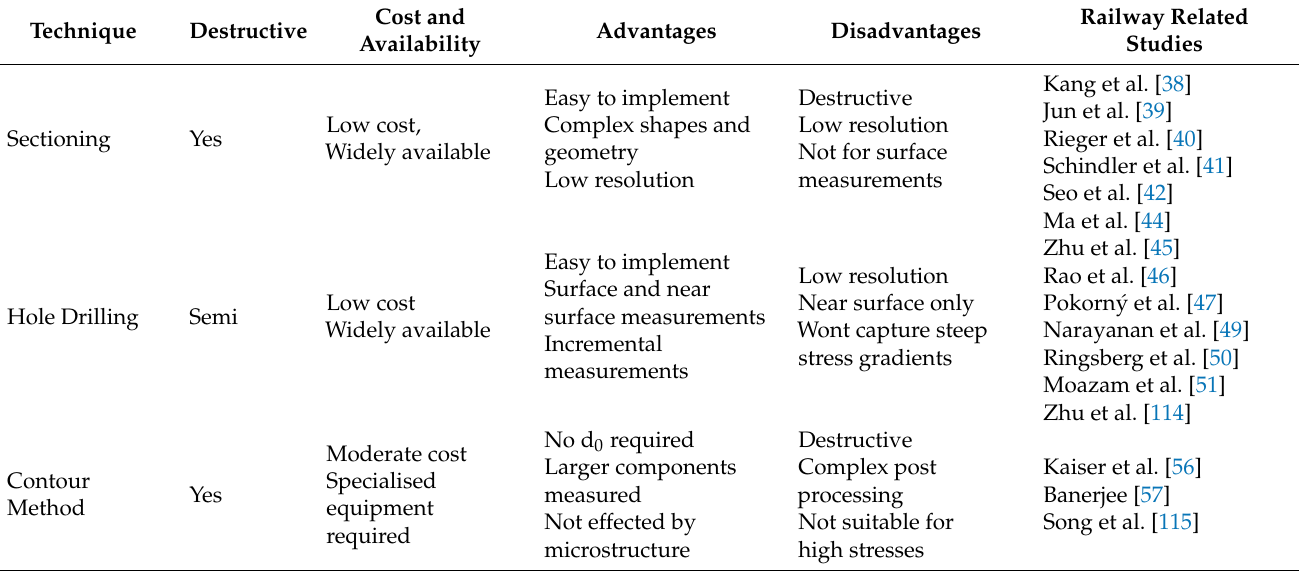
Table 4. Comparison of advantages and disadvantages of residual stress measurement